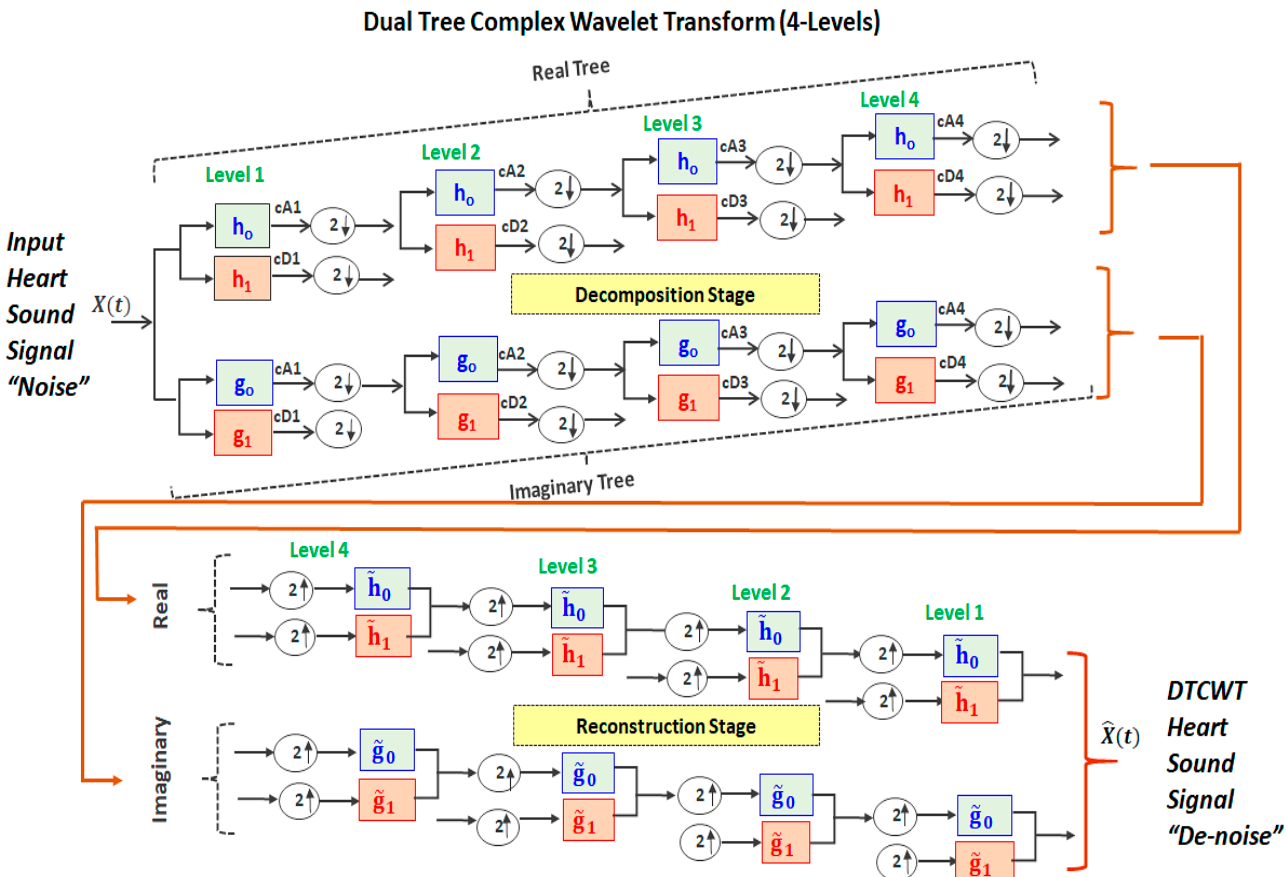
Figure 2. One-dimensional DTCWT illustrating the filter banks during both the decomposition and reconstruction stages. X ( t ) represents the input signal; cA1, cA2, cA3, and cA4 denote the approximate coefficients at level 1, level 2, level 3, and level 4, respectively; while cD1, cD2, cD3, and cD4 denote the detail coefficients at level 1, level 2, level 3, and level 4, respectively. The upper and lower trees show the real and imaginary parts of the X ( t ) signal processing. The average signal is presented as an output ˆ X ( t )